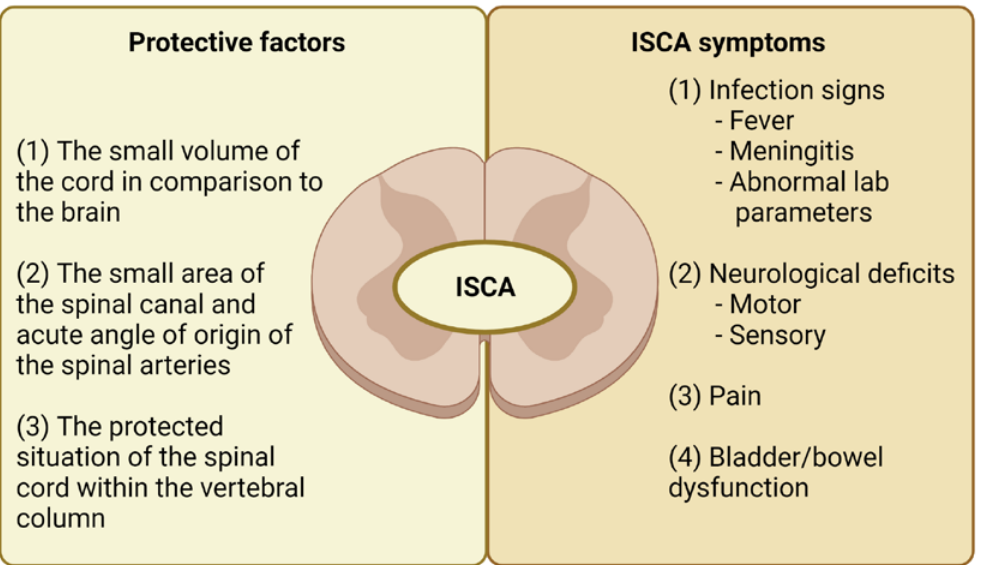
Figure 1. The protective factors and typical symptoms of intramedullary spinal cord abscess. Legend: ISCA—intramedullary spinal cord abscess.